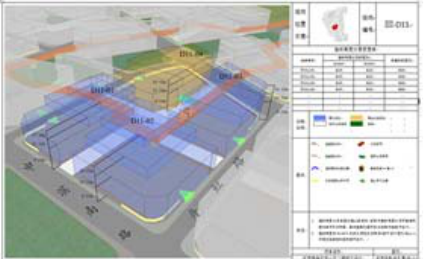
Figure 1. The definition of control and guidance for three- dimensional business district space